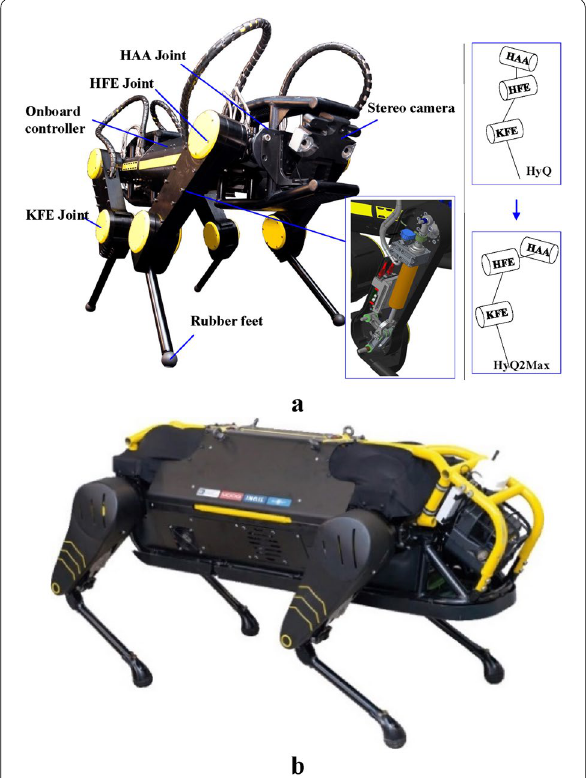
Figure 1 HyQ robots: a HyQ2Max [11]; b